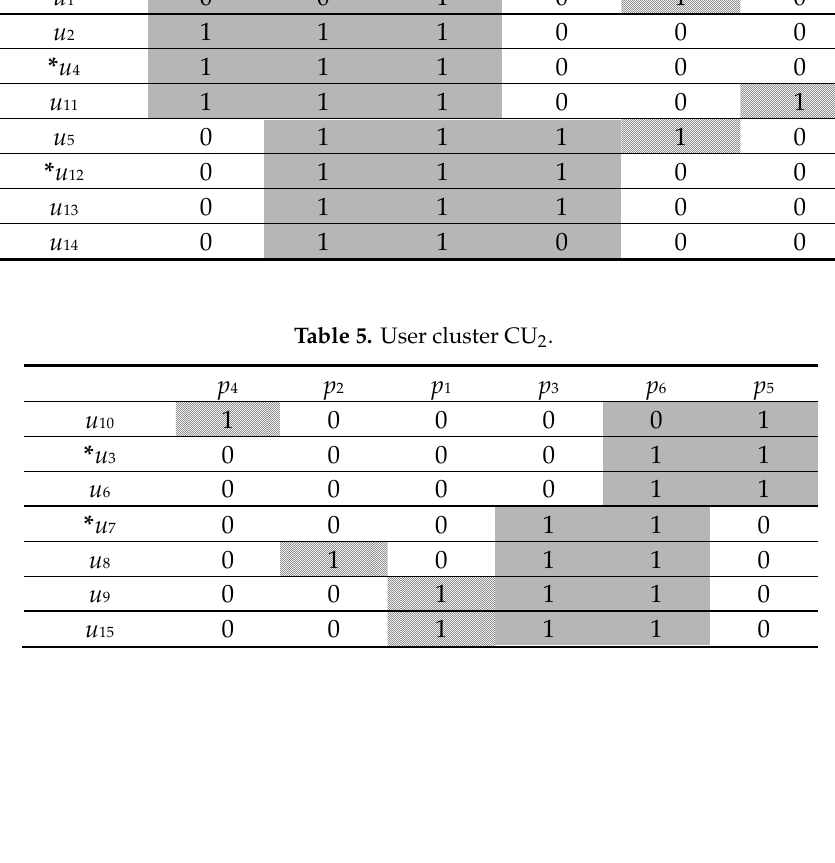
Table 4. User cluster CU 1 .